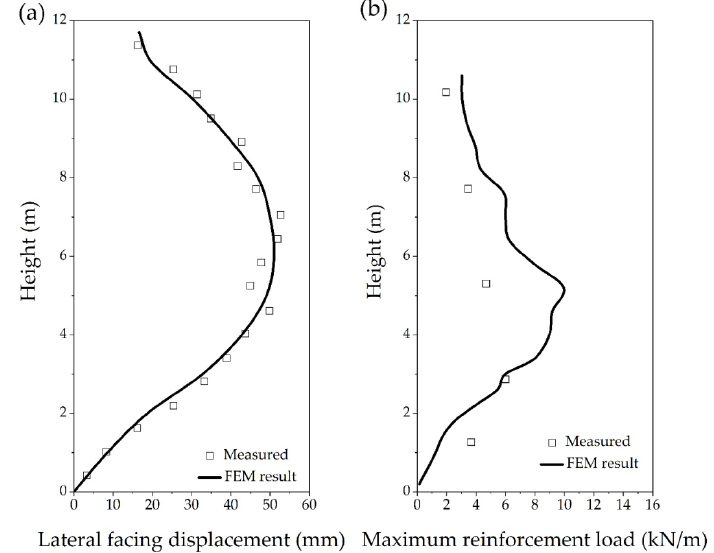
Figure 4. Comparison of the calculated and measured values: ( a ) lateral facing displacement; ( b ) maximum reinforcement load.